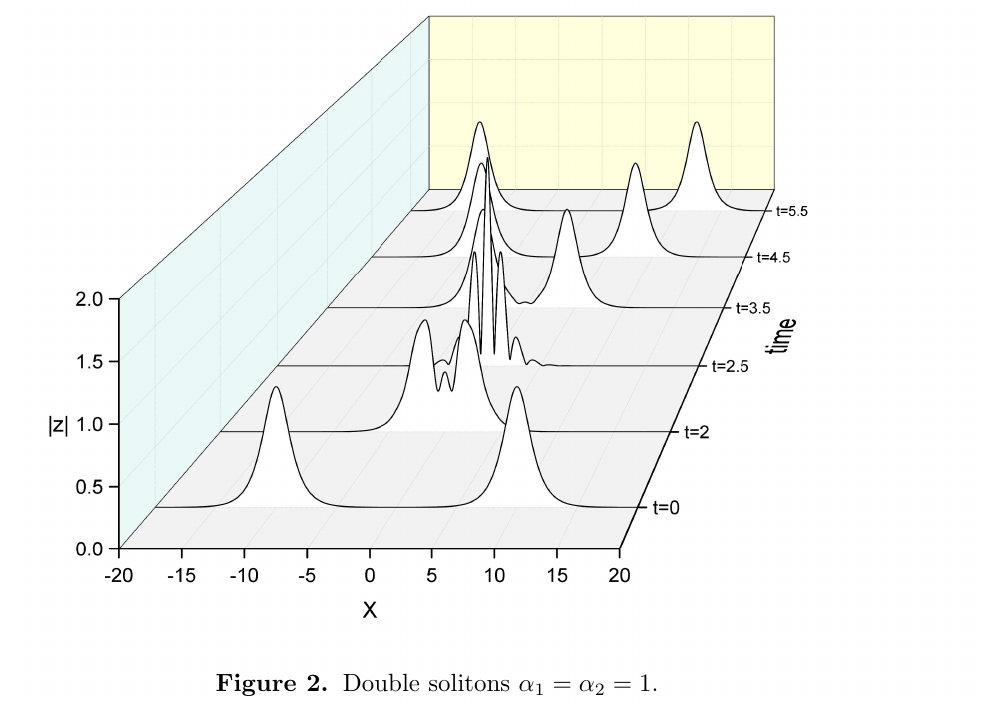
Figure 2. Double solitons α 1 = α 2 = 1. Table 6. Invariants and relative changes of invariants of double solitons: α 1 = α 2 = 1 Present (FDM-DQM) Cub. Coll. [15] Quad.Gal.